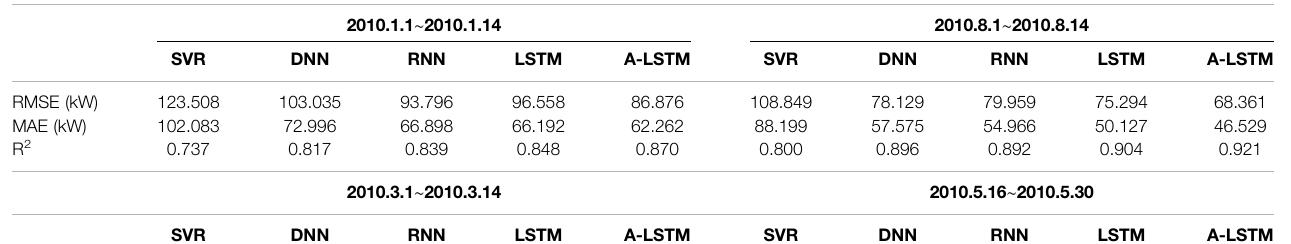
TABLE 5 | Performance of A-LSTM models compared to the baseline